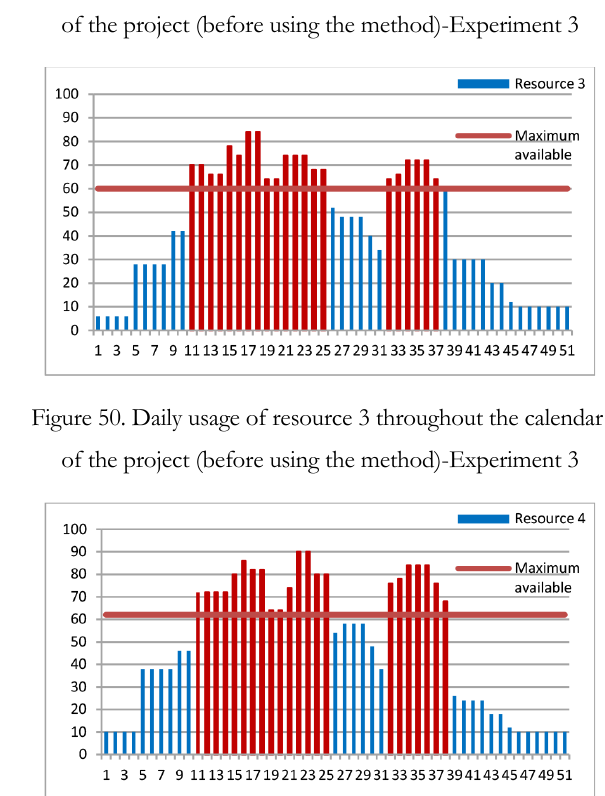
Figure 53. Daily usage of resource 4 throughout the calendar of the project (before using the method)-Experiment 3